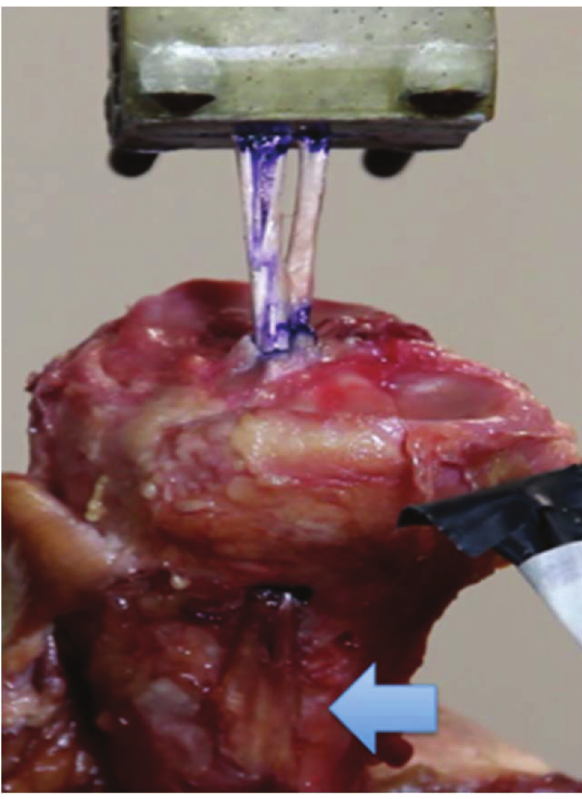
Figure 5 - Photo of an anatomical piece of the tibia from group B (fixation with screw) showing the mechanical trial with the Kratus apparatus in which the tibia was maintained on an immobile support. Arrow: Freed insertion of the hamstring tendons fixed with an interference screw inside the tunnel.